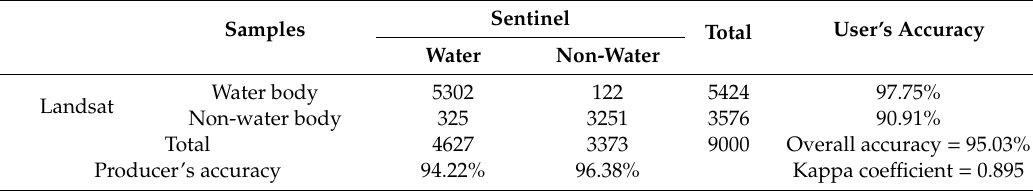
Table 1. The confusion matrix for accuracy assessment of this